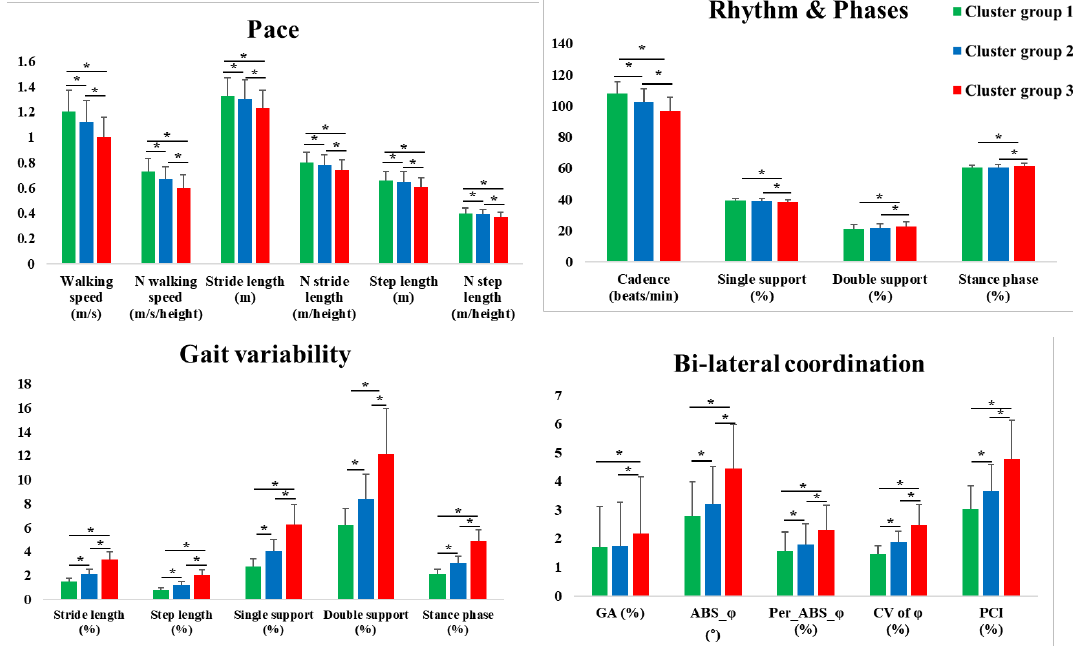
Figure 3. Results of pace, rhythm, phases, gait variability (GV), and bilateral coordination according to the cluster groups. The cluster groups are divided based on the stride length and stance phase. * denotes a significant difference. P < 0.0167.